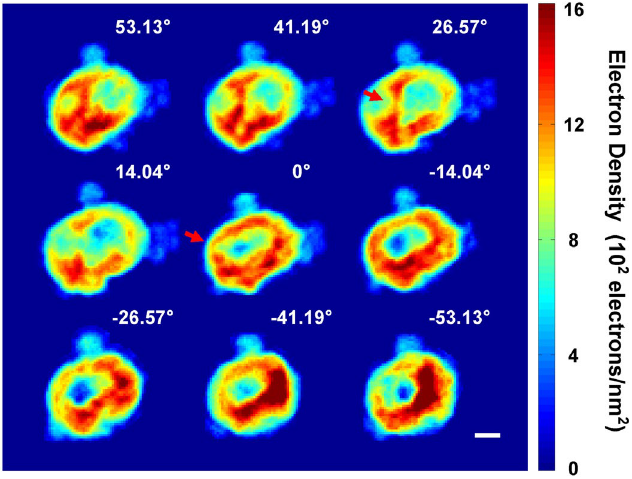
Figure 2. Representative projection 2D CXDI images selected from total of 26 images. They are reconstructed from the diffraction profiles measured at the corresponding projection angles, and represent the electron density map integrated along the beam direction. As the projection angle changes, the image of the inner low density area changes consistently. Some images show noticeable density variations over two or three pixels as indicated by an arrow. The scale bar is 400